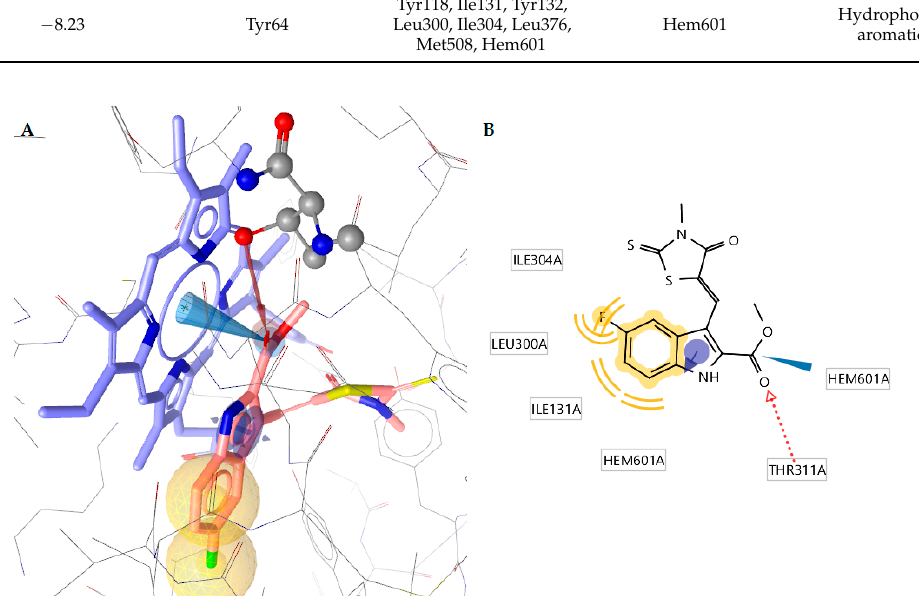
Figure 5. Docked conformation of the most active compound 15 in lanosterol 14 α -demethylase of C . albicans (CYP51 ca ). ( A ) 3D representation of compound 15 . ( B ) 2D representation. Red dotted arrows indicate H-bond, blue arrows indicate aromatic interactions, and yellow spheres indicate hydrophobic interactions.